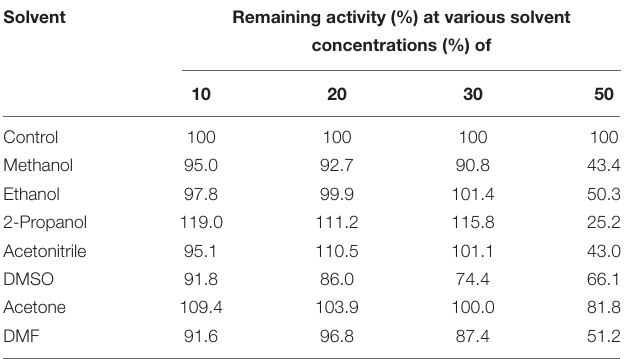
TABLE 1 | Effects of organic solvents on the EstC1.